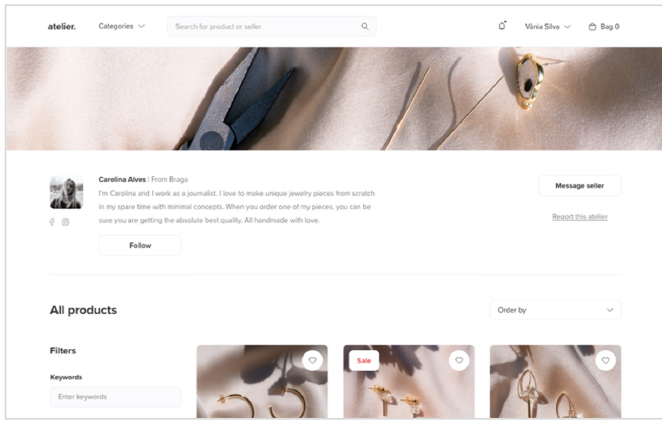
Figure 11. Design change: Follow button. Self-source, 2020.